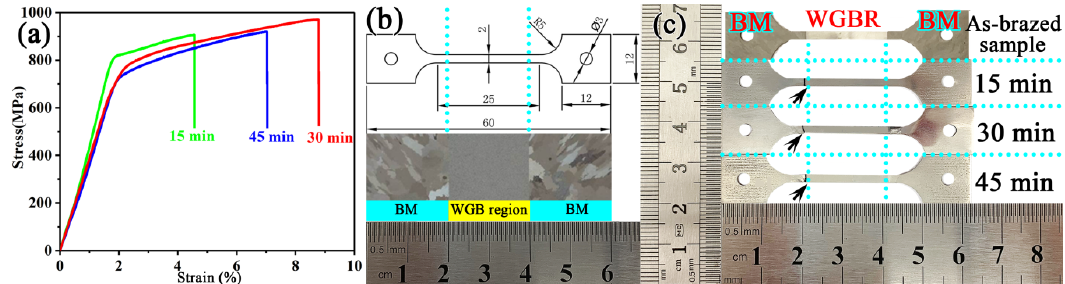
Figure 5. Tensile stress–stain curves of the as-brazed specimens bonded for different times ( a ), the illustration of the brazing process of the K417G alloy tensile test specimen ( b ), and morphology of the failed specimens ( c ) (BM—base metal, WGBR—wide-gap brazed region).